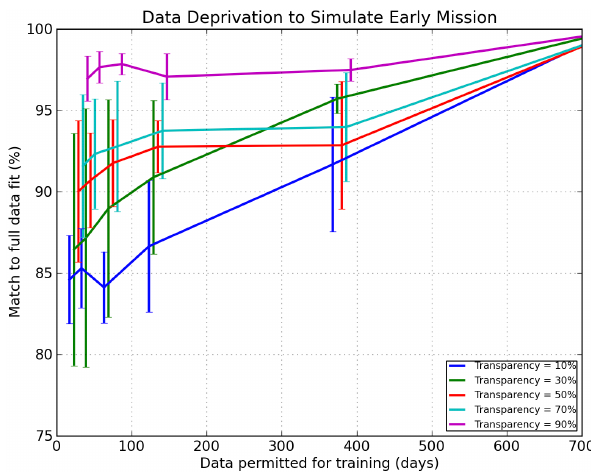
Figure 16. Using only two weeks of randomly selected training data, at least 85% and up to 2 Fig. 16. Using only two weeks of randomly selected training data, 96% of the optimal sounding selector was reconstructed. Note that the x-axis has been shifted 3 at least 85% and up to 96% of the optimal sounding selector was by a few days for each successive transparency for readability. The error bars represent the 4 reconstructed. Note that the x axis has been shifted by a few days stddev of the full data match % for the set of subwindows sampled. 5 for each successive transparency for readability. The error bars rep- resent the stddev of the full data match % for the set of subwindows